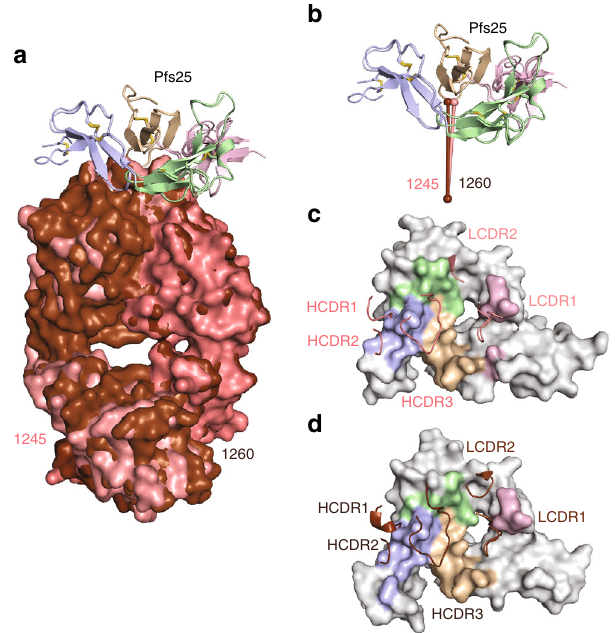
Fig. 5 Molecular details of site 2 antibody recognition. a Superposition of site 2 antibody – Pfs25 co-complex crystal structures. Pfs25s are shown as cartoon and colored according to EGF-like domain as in Fig. 3. 1245 and 1260 Fabs are shown as surface representation and colored in salmon and brown, respectively. b Comparison of the angle of approach. The center of mass for both the Fab variable domains and interacting Pfs25 residues are shown as spheres and colored as in a . CDR loops that interact with Pfs25 for c 1245 and d 1260. Non-interacting Pfs25 residues are colored gray, while interacting residues are colored according to their EGF-like Kymouse E-80-1c) and 1276 (memory B cell-derived from Kymouse E-80-1a) are part of a mAb pair, and differ by eight H- chain and 14 L-chain residues. Of these residues, two in the HCDR2 (Thr/Asn53 and Asp/Ser54) and one each in the LCDR2 (Tyr/Phe52) and LCDR3 (His95B/Arg95) contact Pfs25.